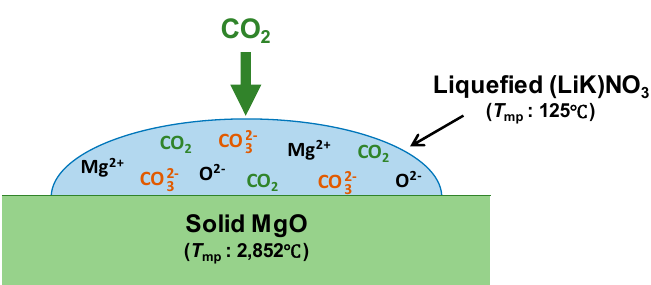
Figure 5. Carbonation mechanism of (LiK)NO 3 /MgO [23].